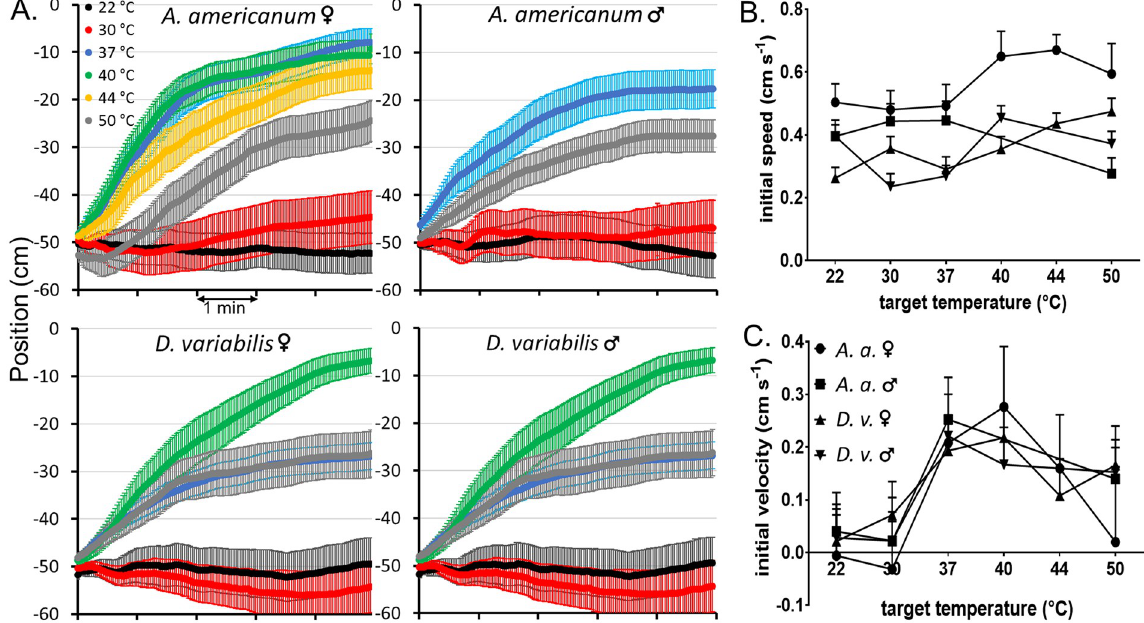
Fig 4. Average movement of ticks in thermotaxis trials. A. Average longitudinal position vs. time in the thermotaxis arena of the indicated ticks after placement in the center at -50 cm with respect to the warm target at 0 cm. Horizontal axis units are minutes. B. Average initial speed and C. average velocity of ticks during the first 10 seconds of thermotaxis